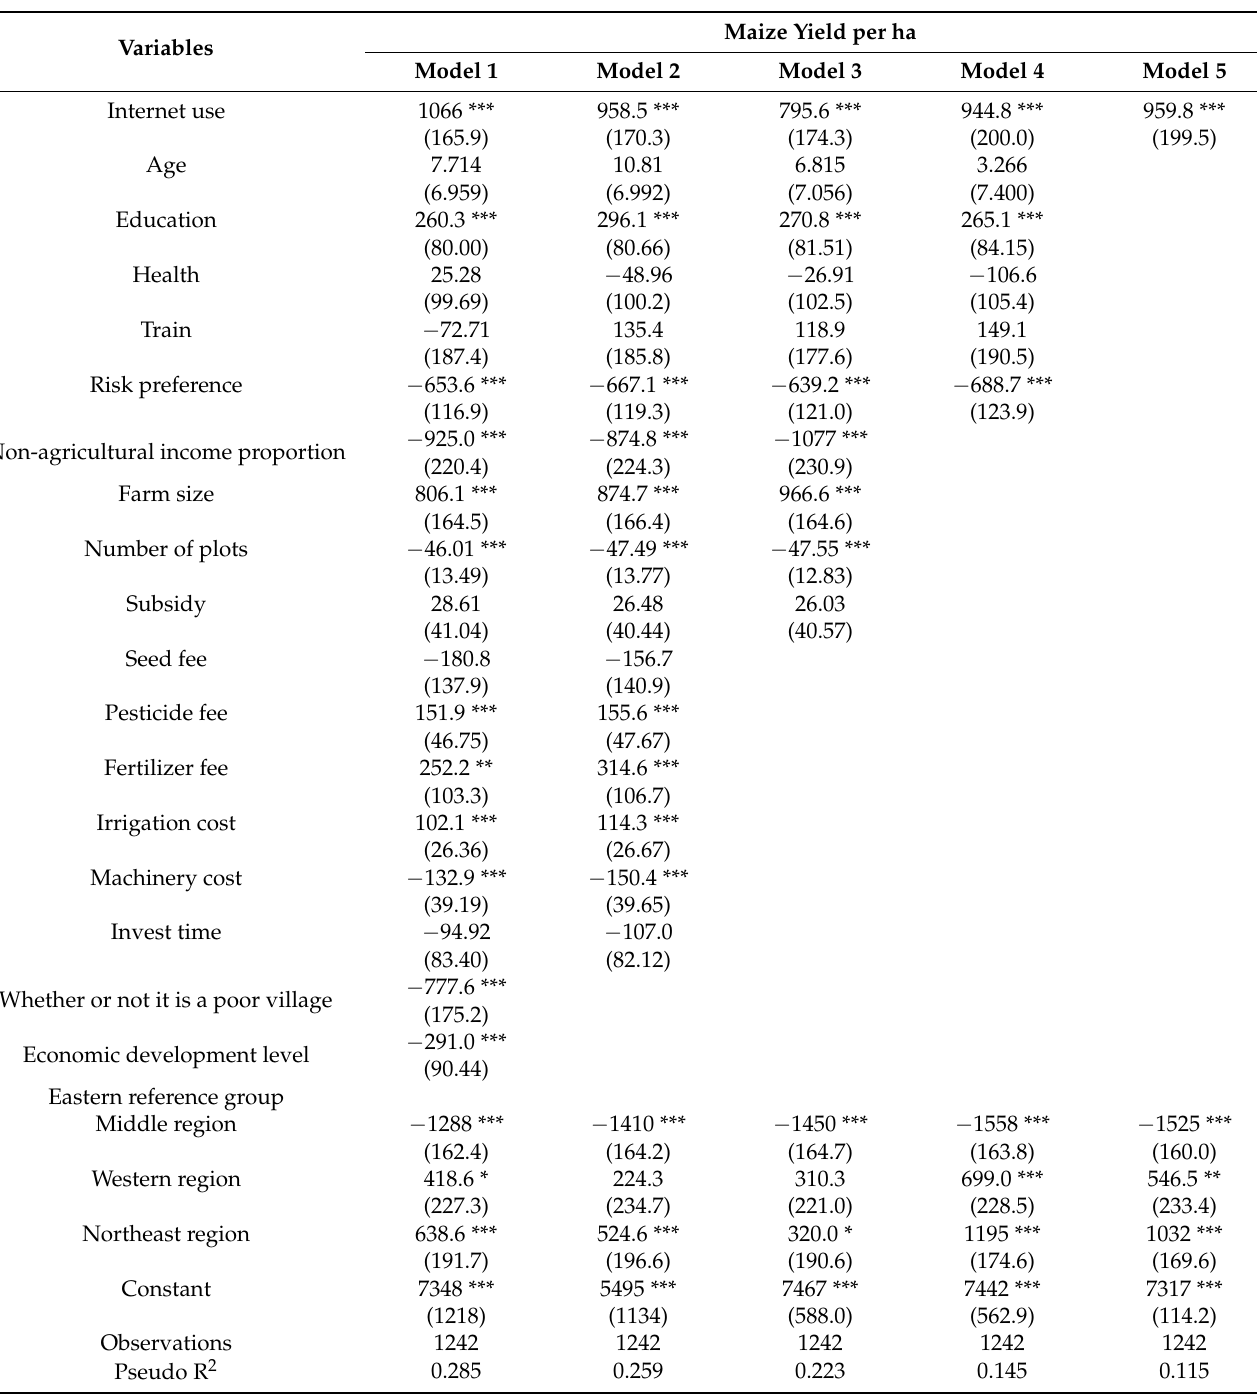
Table 3. The linear regression results of the impact of Internet use on grain